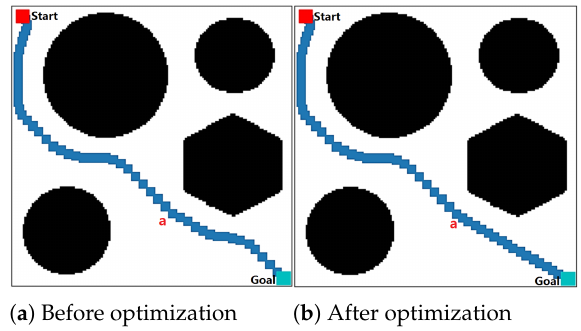
Figure 11. Path optimization on 200 × 200